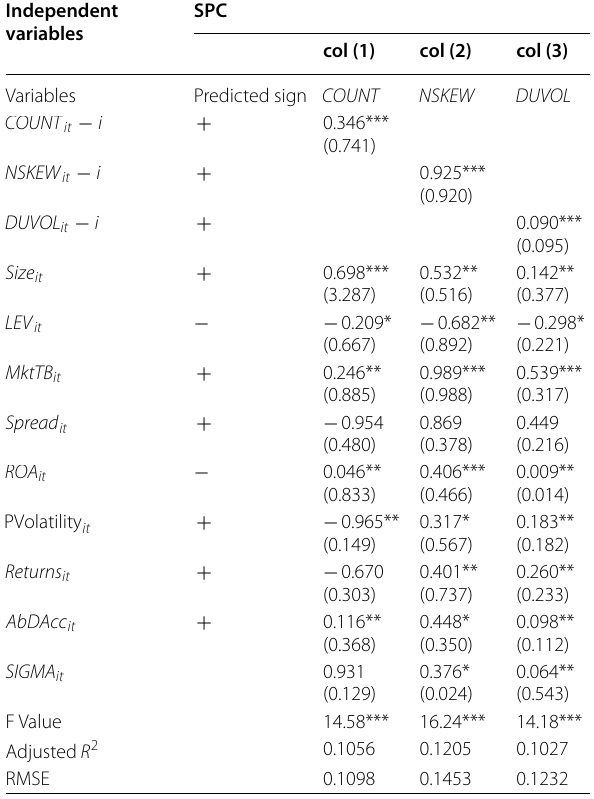
Table 3 Spillover outcome of SPC